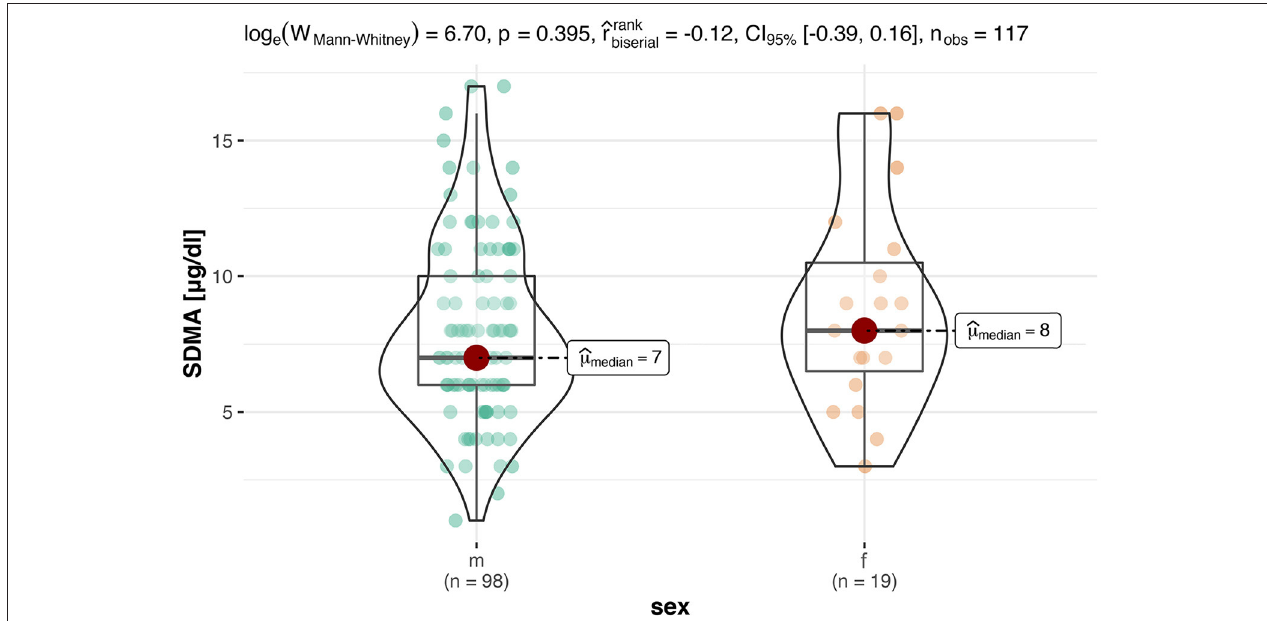
FIGURE 1 | This box-violin-plot shows the distribution of SDMA levels in both sexes without animals from Neumeunster Zoo. The colored dots represent each individual data point, while the shape of the bean plot represents its density. In addition, the minimum and maximum values as well as the median are shown as boxplots.